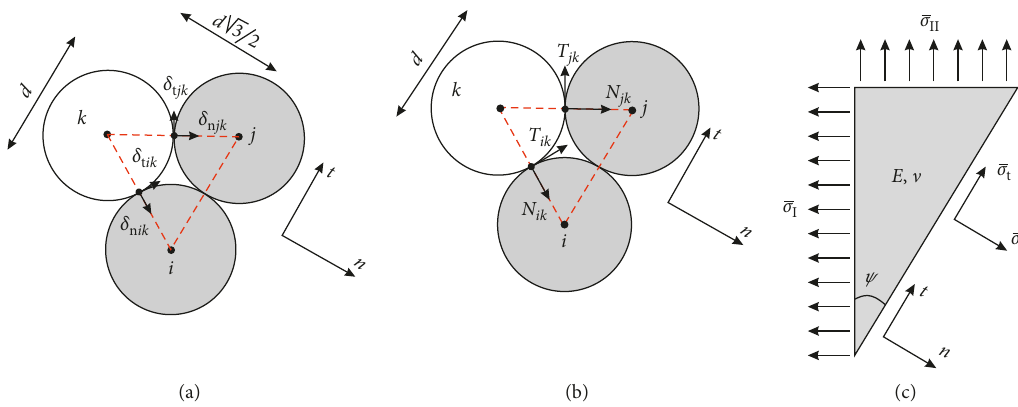
Figure 3: (a) Contact displacements and (b) contact forces of respective adjacent particles. (c) Mean stresses and the orientation of their principal values